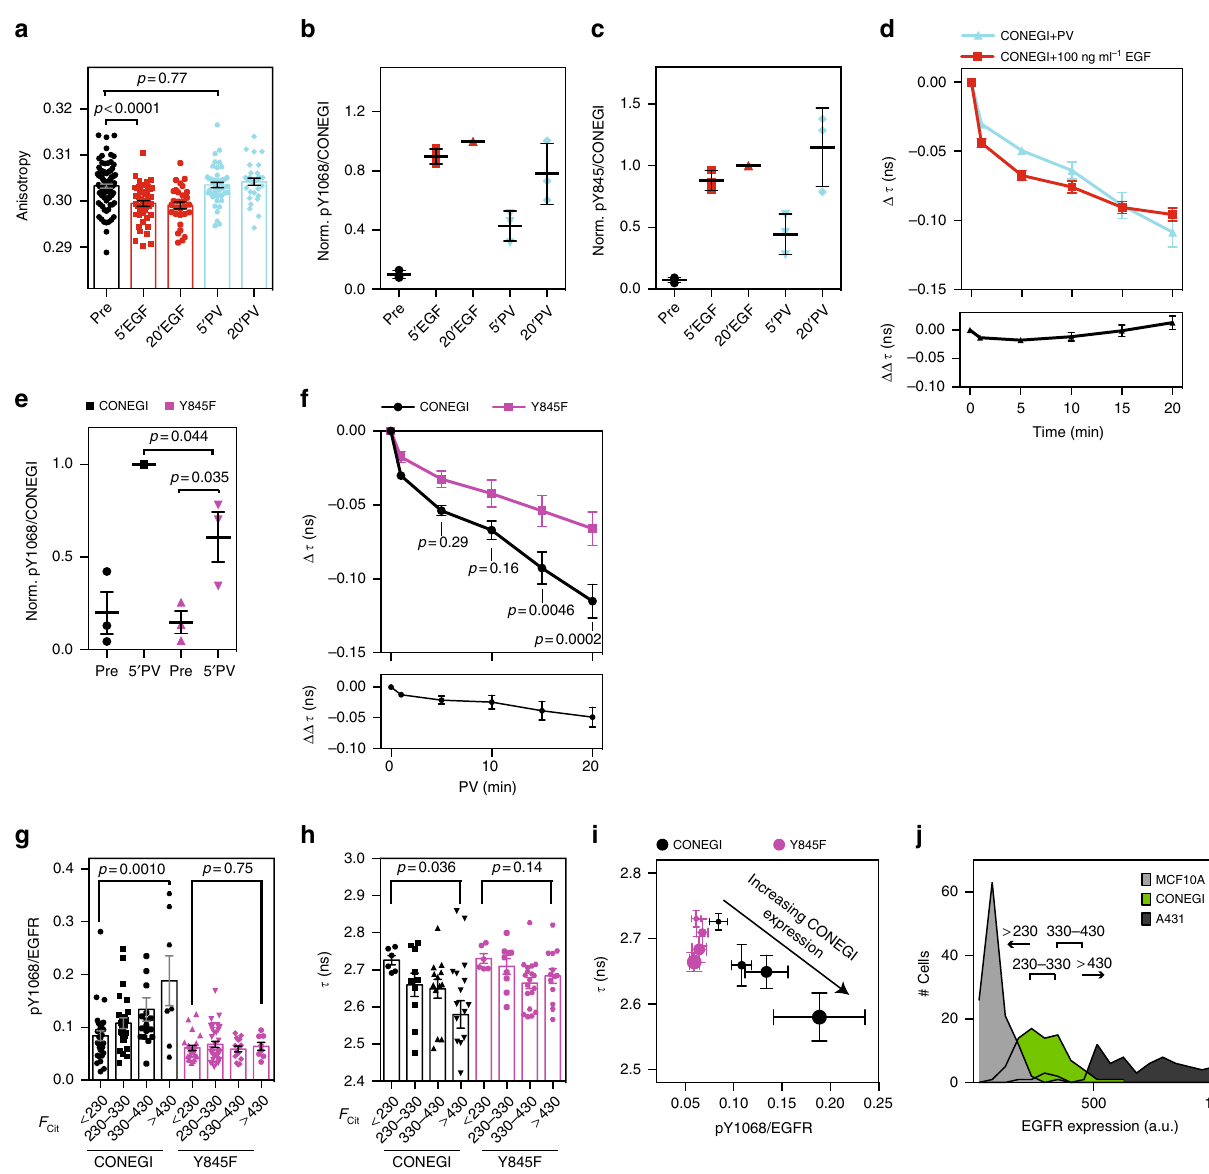
Fig. 3 Y 845 phosphorylation induces an active conformation of EGFR monomers. a Mean mCitrine fl uorescence anisotropy of CONEGI upon EGF or pervanadate (PV) treatment (Supplementary Fig. 3a, b) ( N = 3 experiments; n = 30 – 47 fi elds of view/condition; unpaired two-tailed t -test). b , c Normalized relative Y 1068 (pY 1068 /CONEGI) ( b ) or pY 845 phosphorylation (pY 845 /CONEGI) ( c ) of CONEGI upon EGF or PV treatment by western blot analysis ( n = 3) (Supplementary Fig. 3e, f). d Change in Δ τ of CONEGI (upper panel) at the PM and the difference between EGF and PV treatment ( ΔΔ τ ) (lower panel) (EGF: n = 19 cells; PV: n = 6) (Supplementary Fig. 3g). e Normalized relative Y 1068 phosphorylation (pY 1068 /CONEGI) of CONEGI or CONEGI-Y845F upon PV treatment by western blot analysis ( n = 3; unpaired two-tailed t -test) (Supplementary Fig. 3i). f Change in Δ τ of CONEGI and CONEGI-Y845F upon PV treatment (upper panel) and the difference ( ΔΔ τ ) between CONEGI and CONEGI-Y845F (lower panel) (CONEGI: n = 6